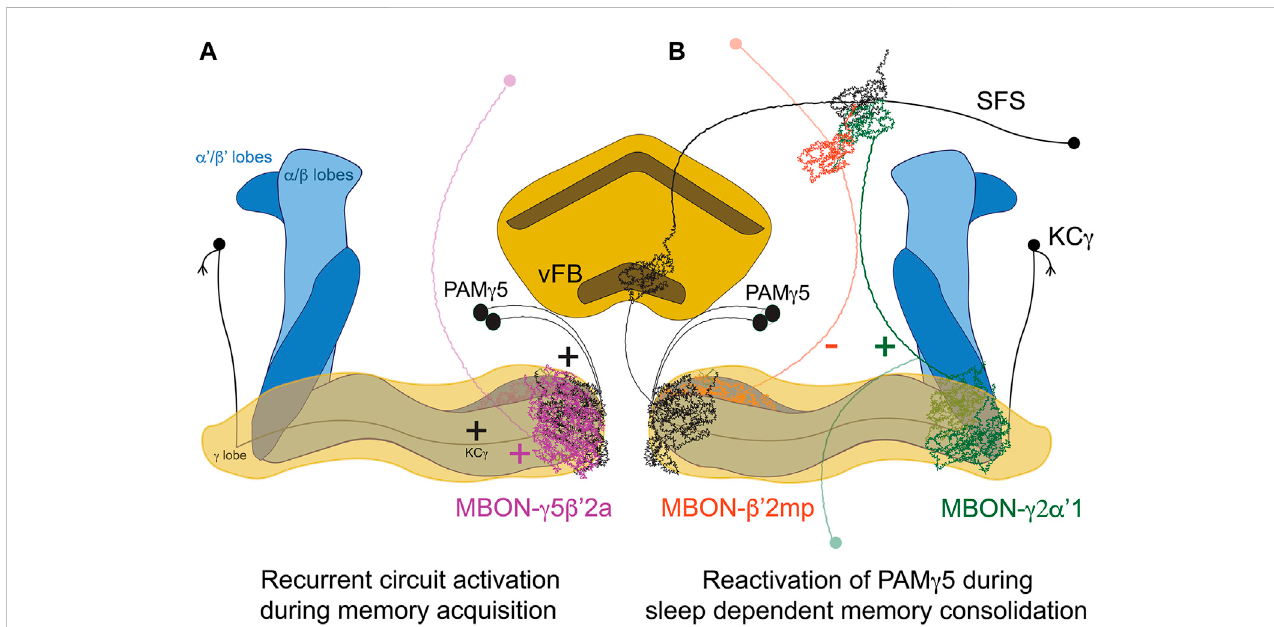
Circuit for sleep-dependent consolidation of courtship memory. (A) Recurrent activation of the microcircuit formed by KC γ , MBON- γ 5 β ’ 2a and PAM γ 5 leads to prolonged activation of the DANs, levering memory formation. (B) . MBON- γ 2 α ’ 1 activates the vFB through SFS neurons, promoting sleep and memory consolidation. vFB projections to KC- γ 5 mediate circuit reactivation during sleep. In contrast, the activity of MBON- β ’ 2mpduring STM-inducing protocols inhibits SFS/vFB and promotes wakefulness.